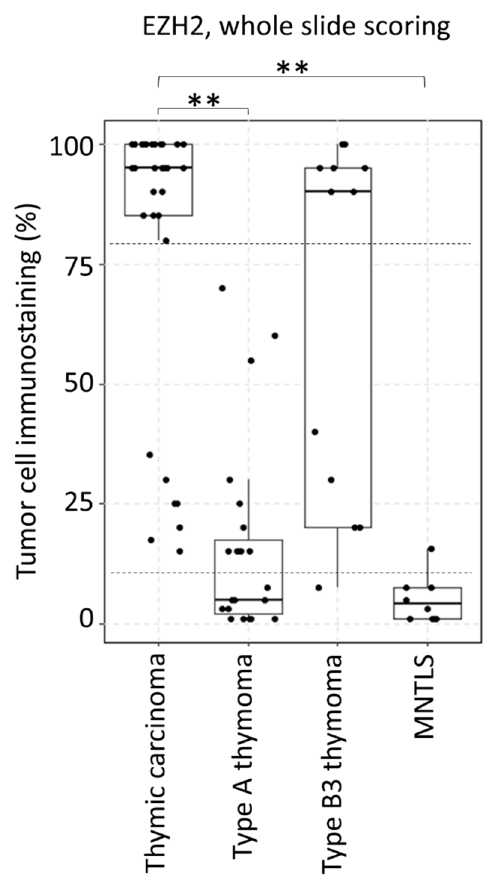
Figure 1. Diffuseness of EZH2 staining, scored across whole tissue slides. The dotted lines indicate 80% and 10% thresholds used for interpreting staining as positive or negative, respectively. ** indicates p < 0.001 in Wilcoxon rank sum tests. MNTLS, Micronodular thymoma with lymphoid stroma. Table 2. Proportion of cases with positive staining for EZH2 and